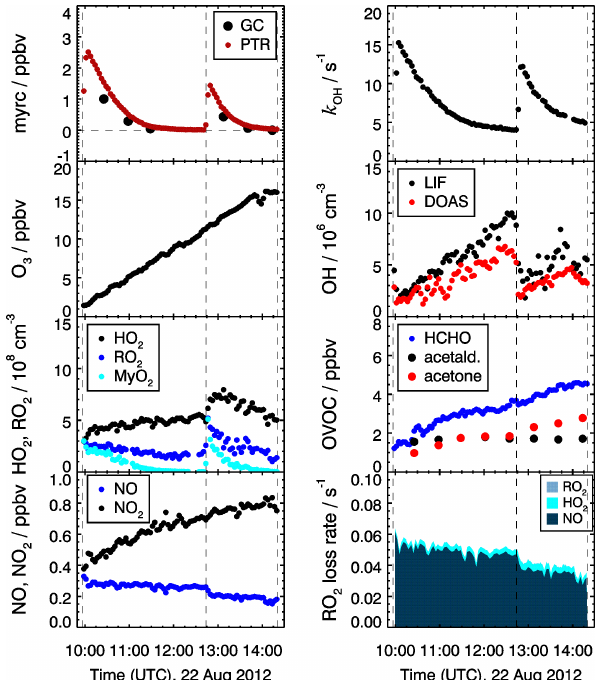
Figure 5. Trace gas and radical concentrations in the chamber ex- periment investigating the OH oxidation of myrcene (myrc) at NO mixing ratios between 200 and 300pptv on 22 August 2012. Peroxy radicals from the reaction of OH with myrcene (MyO 2 ) and total organic peroxy radical (RO 2 = MyO 2 + RO 2 , other ) concentrations are calculated from observed radical concentrations as explained in Sect. 3.4. In the lowest right panel, the loss rates of total RO 2 with respect to their reaction with NO and radical recombination reac- tions are